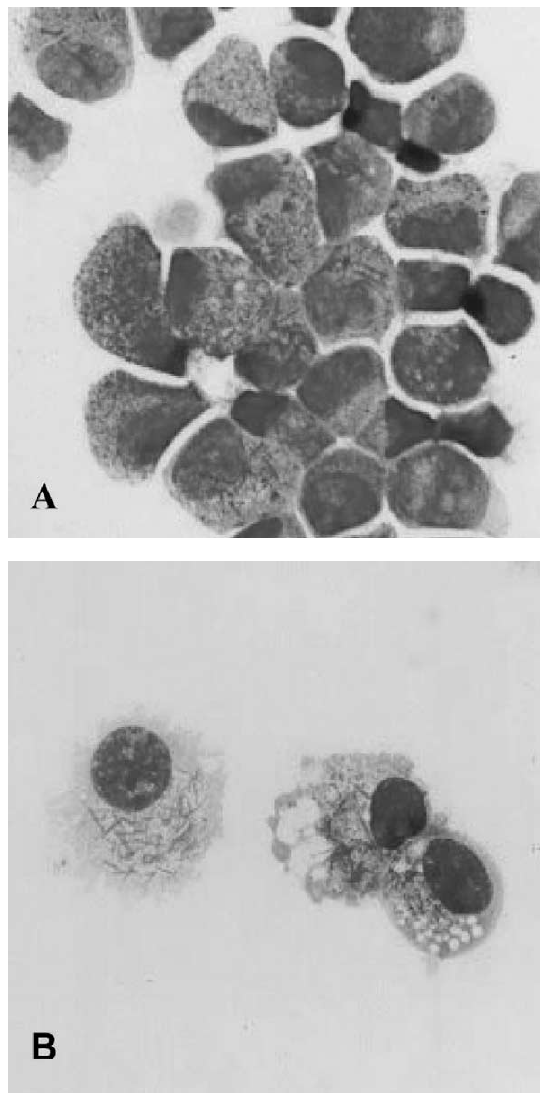
Fig. 1. Morphology of leukaemic cells and leukaemia-derived APCs in APL. APL blast cells are shown in panel A, the CI-cultured APL-APCs in panel B. Cells were spun onto slides and stained with May–Grünwald–Giemsa and evaluated by light microscopy. APCs are enlarged, veiled cells with a decreased nucleus to cytoplasm ratio as compared to blast cells. Auer rods are visible in both cell